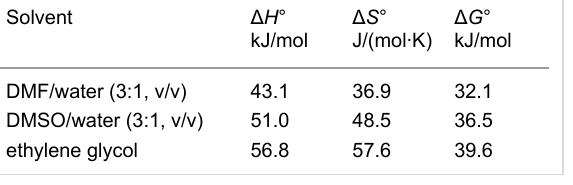
Table 2: Thermodynamic parameters ( Δ H °, Δ S °, and Δ G °) of CT gel ( 3 and 4 , 1:1, molar ratio) in various solvents at 298 K.